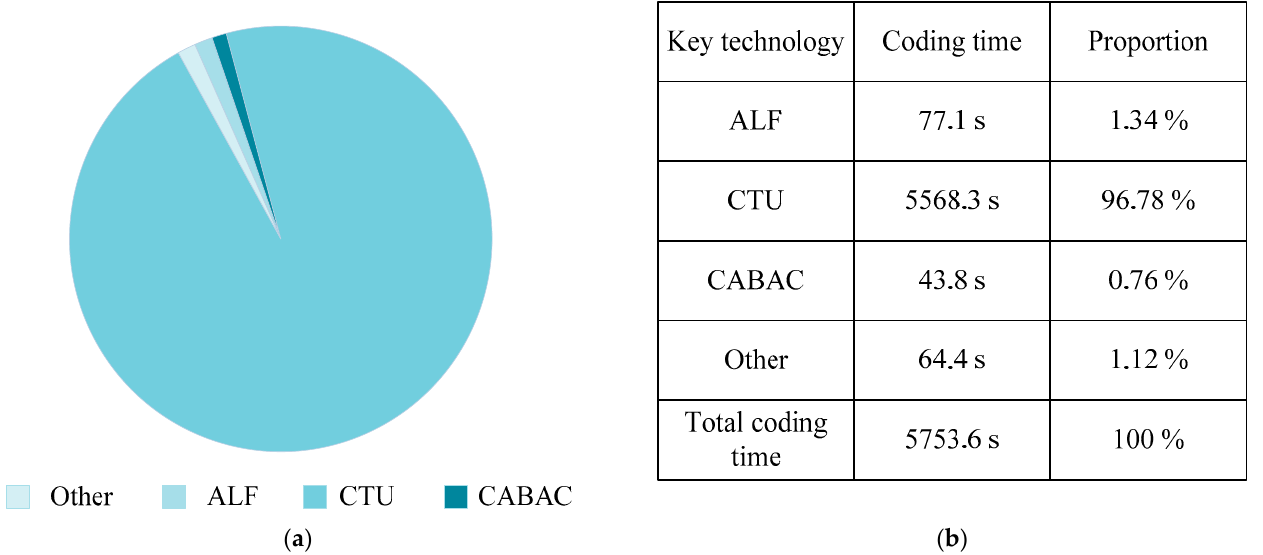
Figure 2. Chart of encoding complexity: ( a ) Scale chart of encoding time occupied by various key technologies; ( b ) scale table of encoding time occupied by various key technologies.